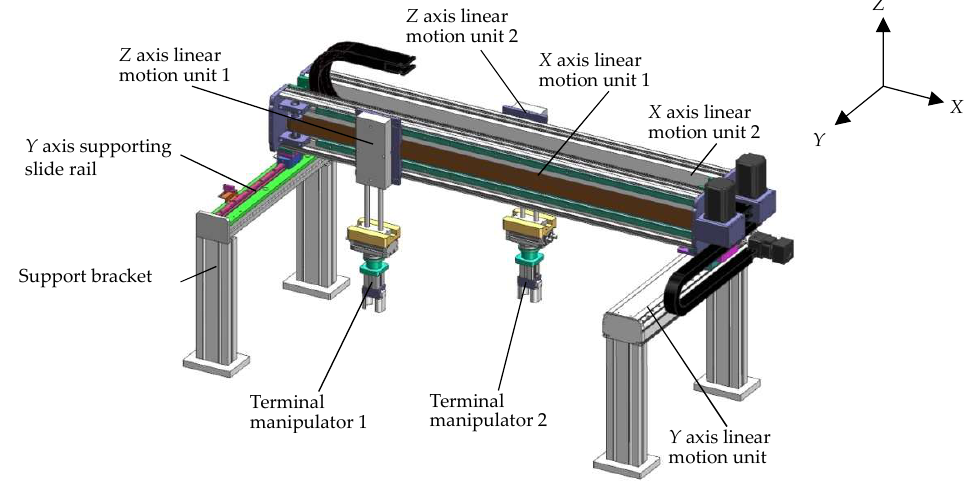
Figure 9. General configuration of the sorting robot.